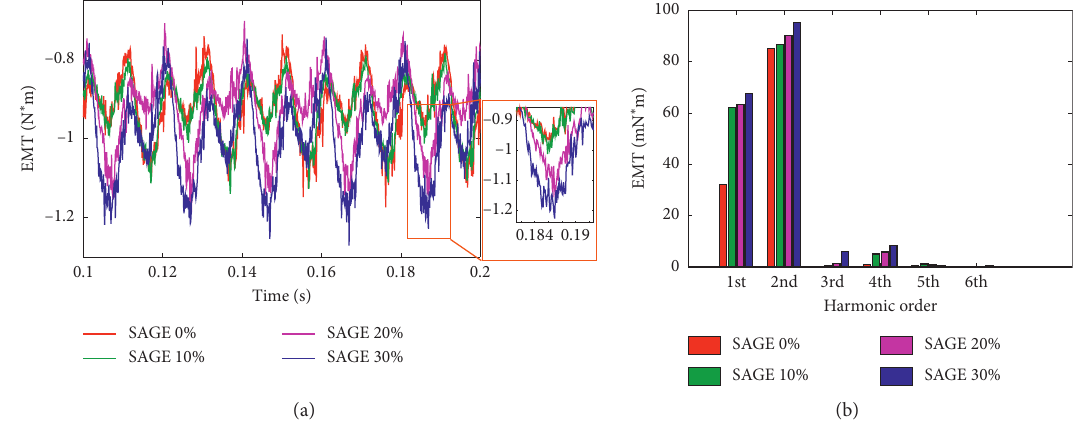
Figure 7: EMT before and after SAGE by experiment: (a) time-domain waveforms and (b)